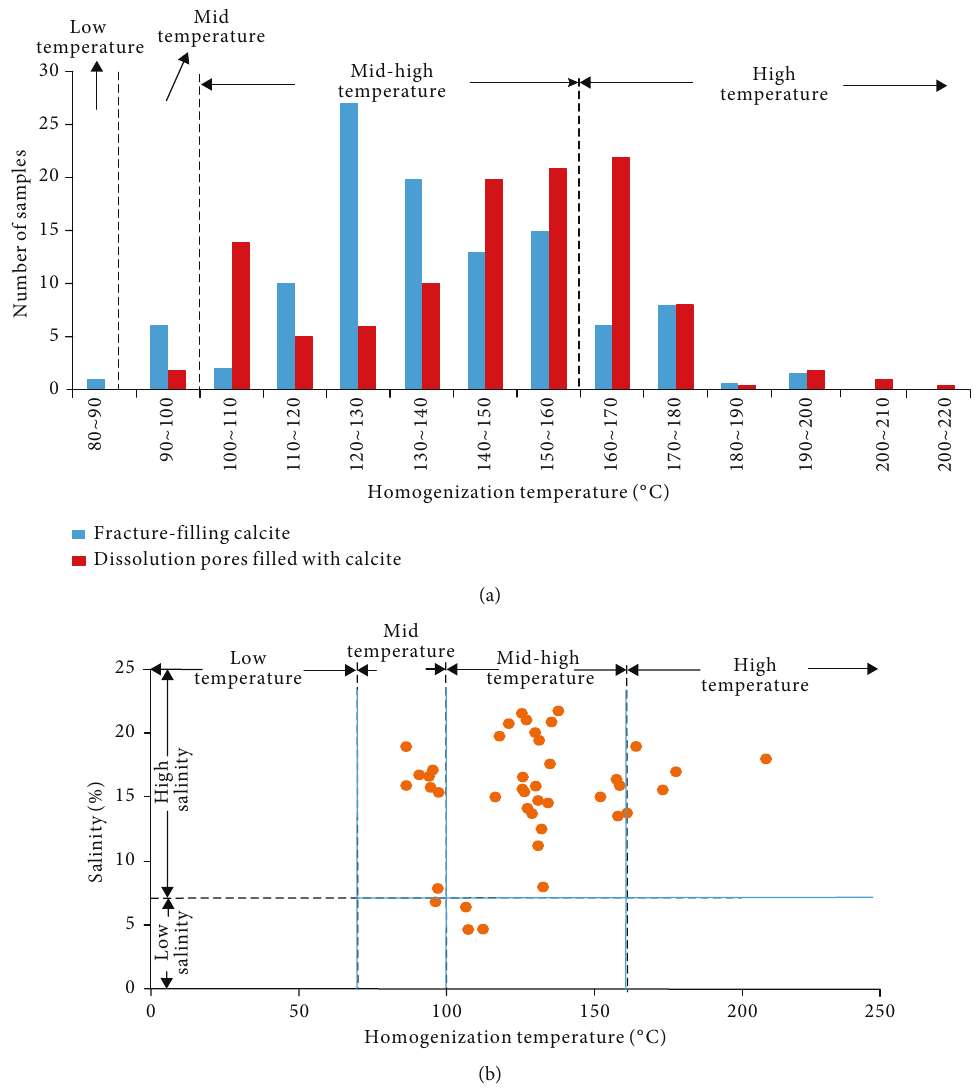
Figure 7: (a) The distribution map of homogenization temperature. (b) The relationship between homogenization temperature and salinity in M5 submember of Middle Ordovician Majiagou Formation in Yan ’ an gas fi 1-2